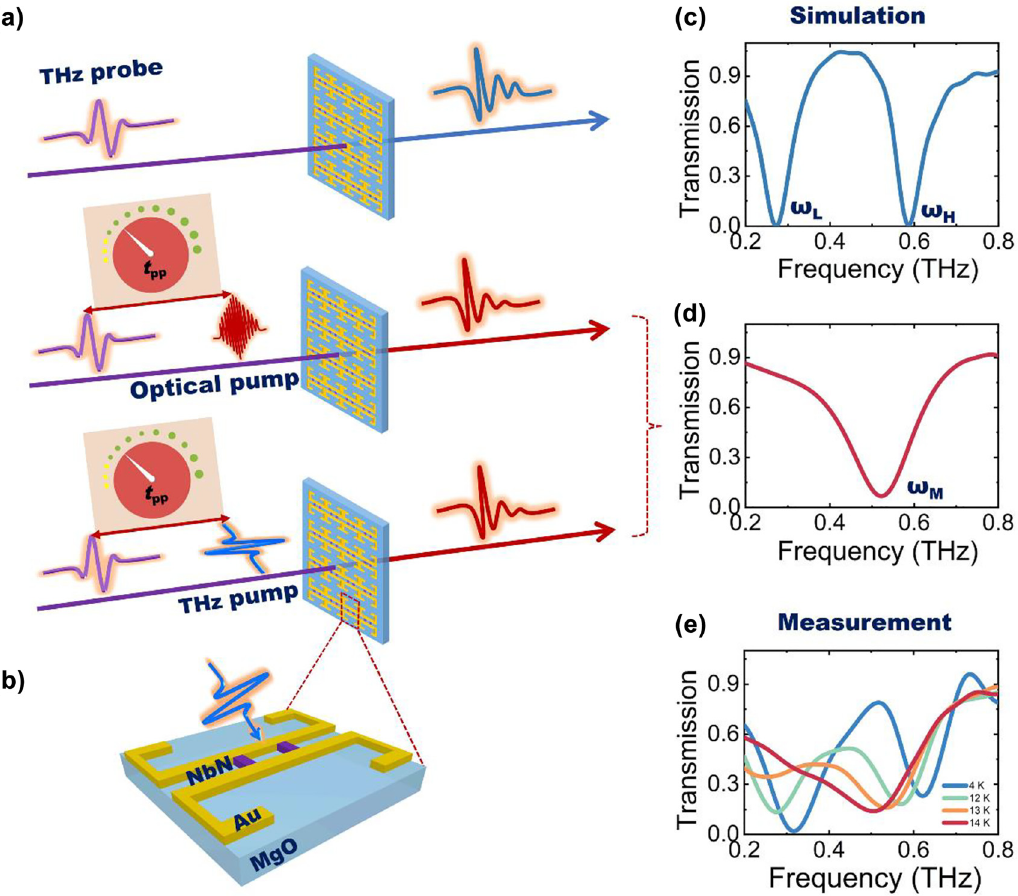
Figure 1: Schematic of THz transmission through hybrid metasurface under different pumps. (a) Schematic of THz probe pulse transmission through the superconductor-metal hybrid metasurface w/o pump or w/optical/THz pumps. Under optical and THz pumps, the pump-probe ) can be regarded as an adjustable knob. The corresponding simulated THz transmission spectra are shown in the right part. delay time ( t pp (b) Close-up of a unit cell of hybrid metasurface under the THz pump. (c) and (d) Simulated THz transmission spectra without and with pump. (e) Measured THz transmission spectra at different temperatures.